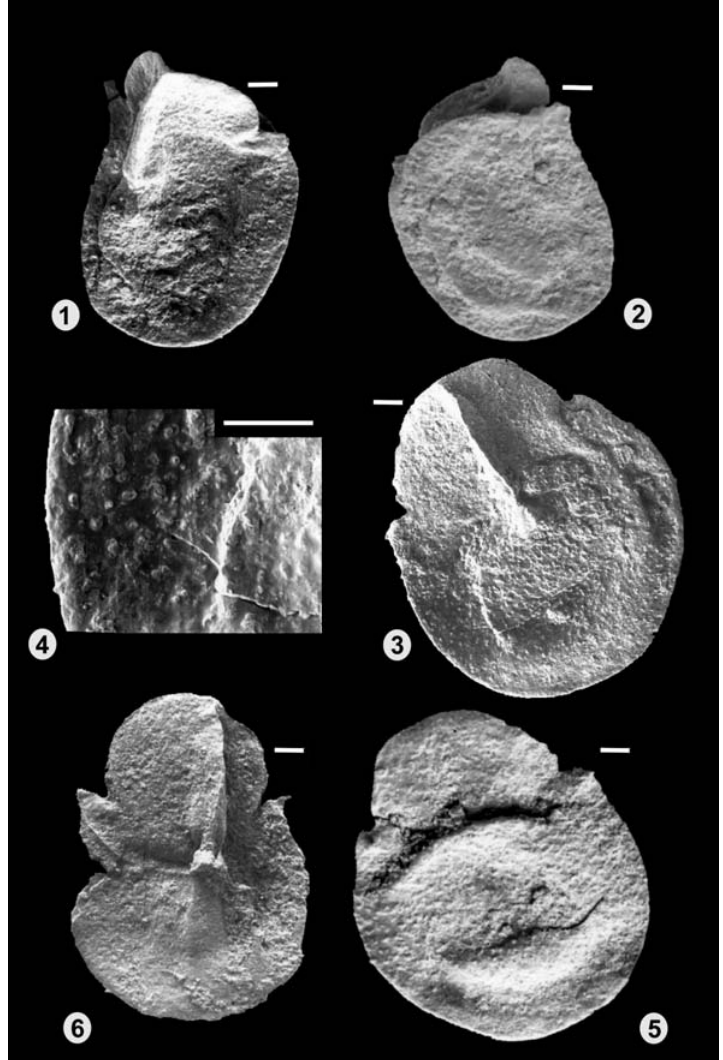
Fig. 4 – Megaspores Lagenoisporites scutiformis : 1. Oblique proximal view (GP/3T 2165); 2. Oblique distal view; 3. Lateral compression (GP/3T 2165); 4. Magnification of fig. 3 showing ornamentation; 5. Oblique distal view of fig. 3; 6. Typical specimen, oblique proximal view (GP/3T 2147). Scale bar = 200 µ m.